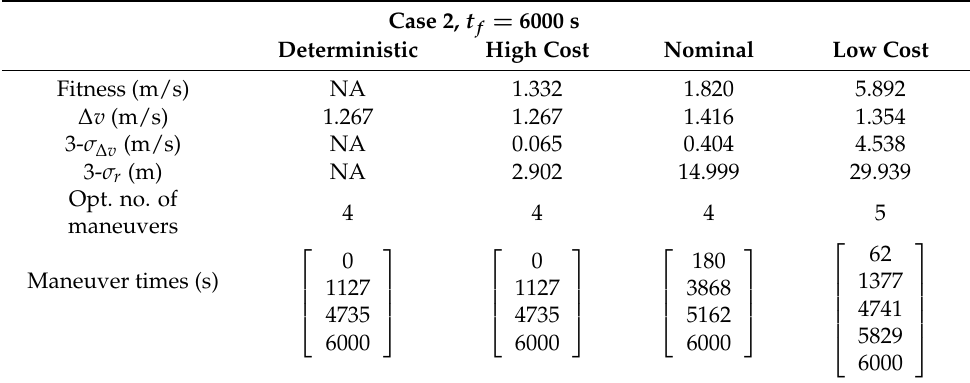
Figure 5. Optimal fitness function with respect to the number of maneuvers when t f = 6000 s. Table 4. Optimal trajectory results when t f = 6000